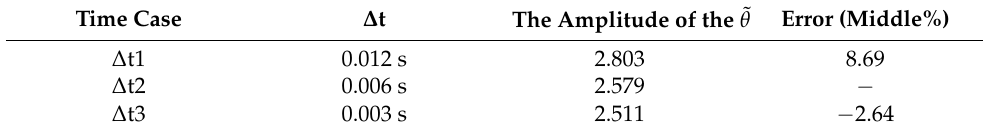
Table 5. Related parameters of three different time steps. Time Case ∆ t The Amplitude of the ˜ θ Error (Middle%) ∆ t1 0.012